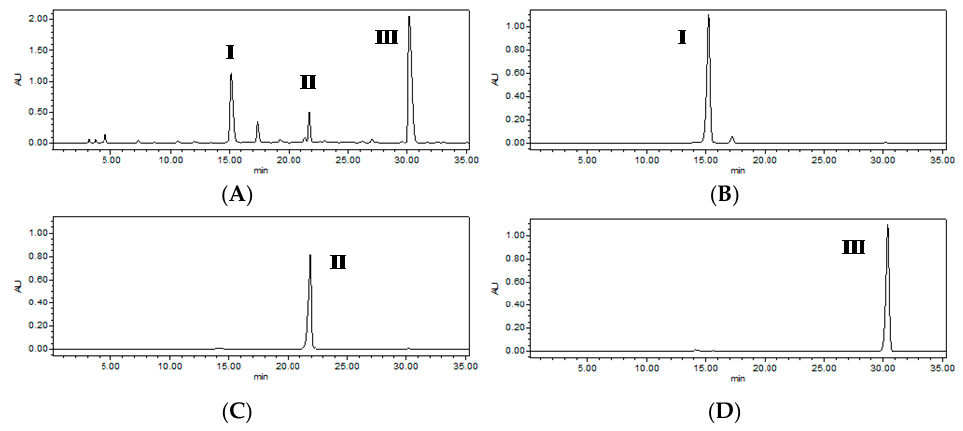
Figure 2. HPLC chromatogram of the crude extract from B. simaoensis ( A ) and the three glucose esters purified by HSCCC separation fraction ( B – D ).